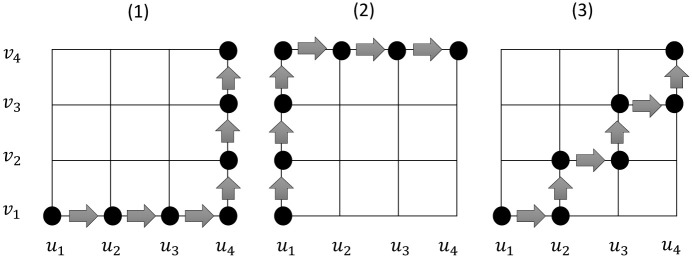
Different ways to pre-select a string of drug combinations with monotonically increasing toxicity for the initial titration design.